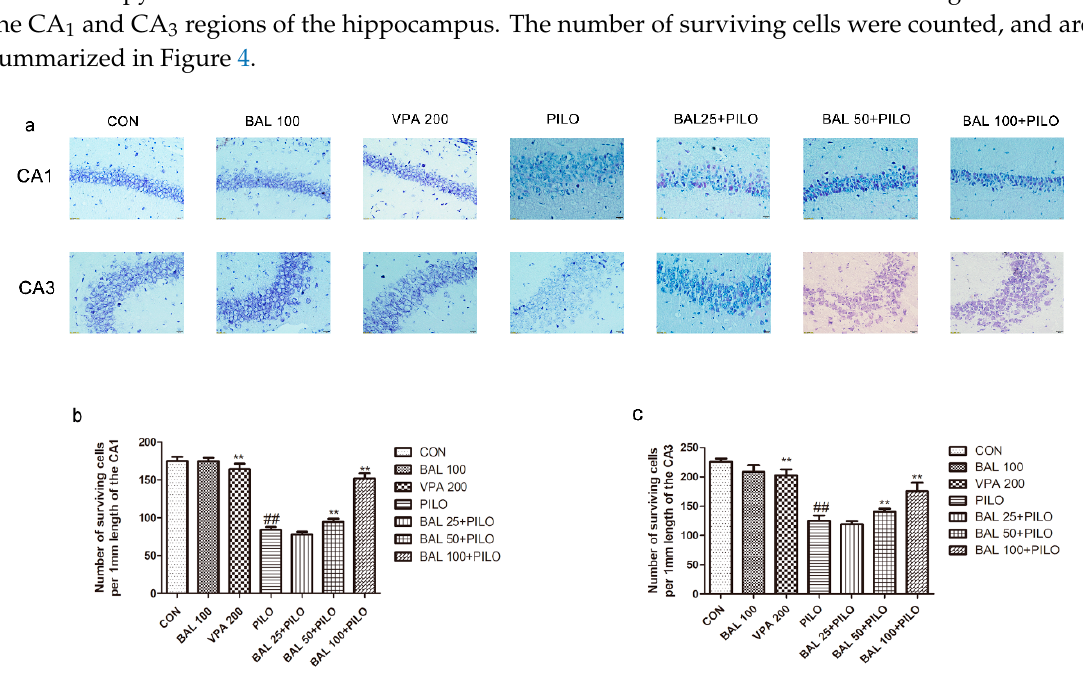
Figure 4. Nissl staining of the hippocampal CA 1 and CA 3 pyramidal neurons with cresyl violet 72 h after convulsion (×400 magnification). Nissl-positive cells in CA 1, CA 3 are shown for ( a ). Bar 20 μ m. The number of surviving neurons in the hippocampal CA 1 ( b ) and CA 3 ( c ). Results are expressed as mean ± SEM ( n = 6). ## p < 0.05 (Student-Newman-Keuls) compared to control group, * p < 0.05 (Student-Newman-Keuls) compared to PILO group, and ** p < 0.01 (Student-Newman-Keuls) compared to the PILO group (One-way ANOVA and the Student-Newman-Keuls).